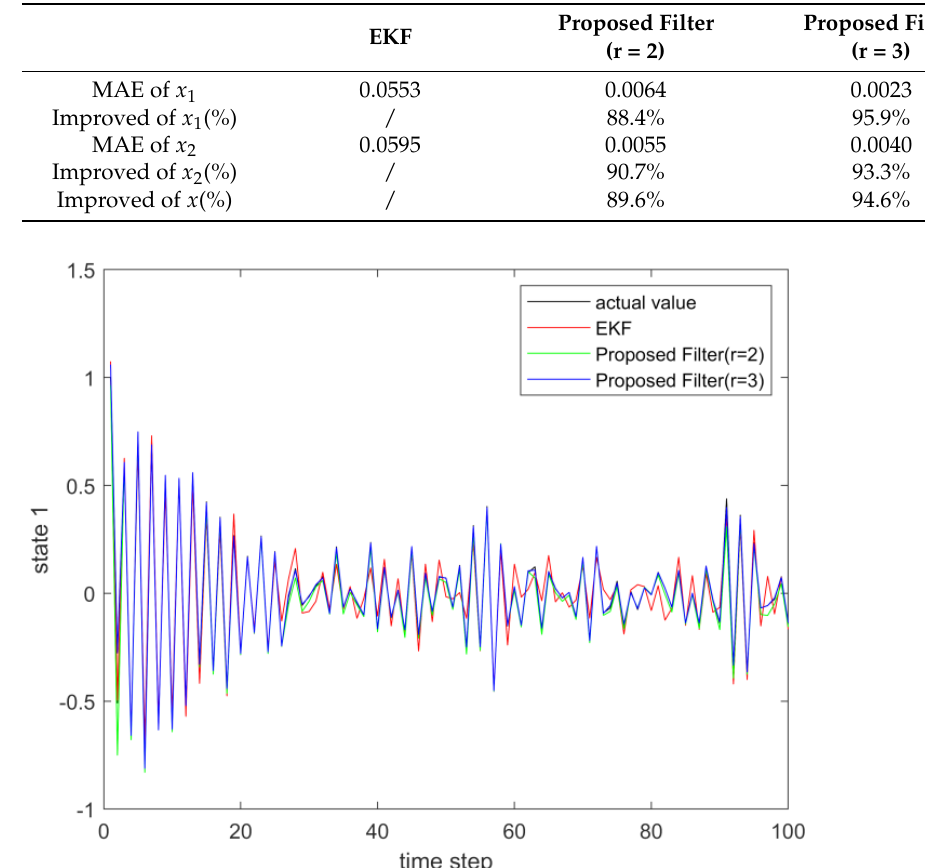
14 of 18 Table 2. Error comparison between the proposed filter and EKF in case 2.